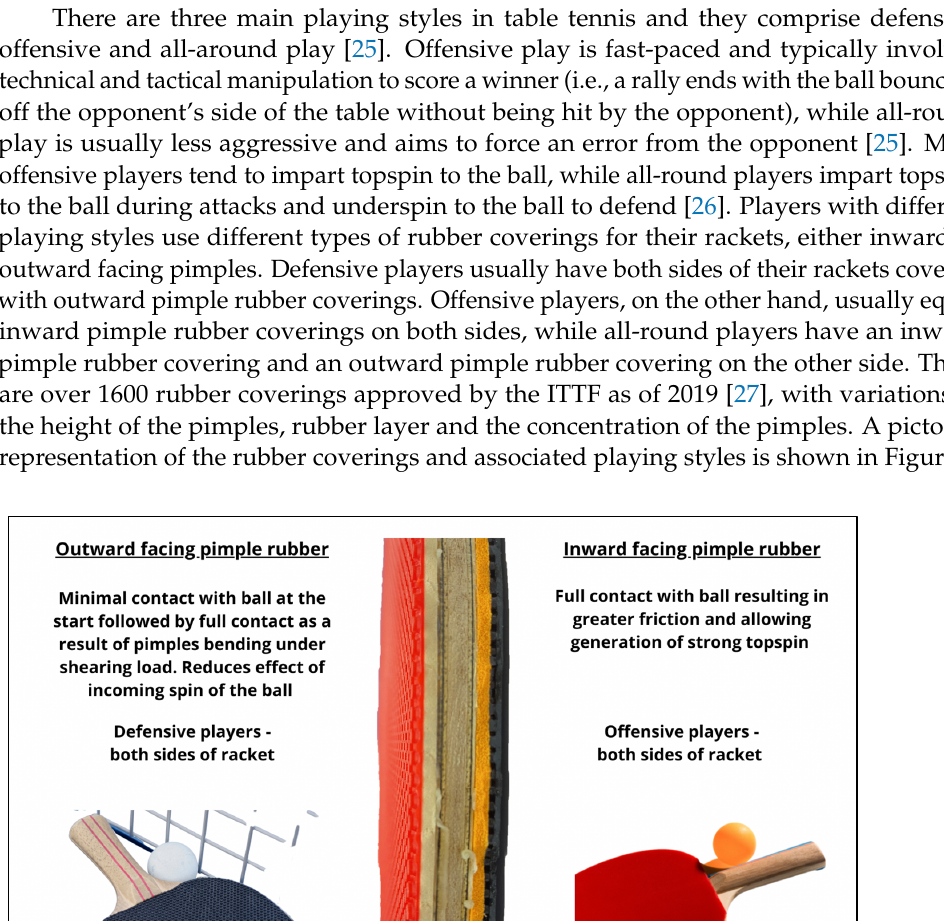
Figure 1. Summary of the physiological demands of table tennis game play and training determined through data collected from official Games and tournaments and simulated game play from research studies.